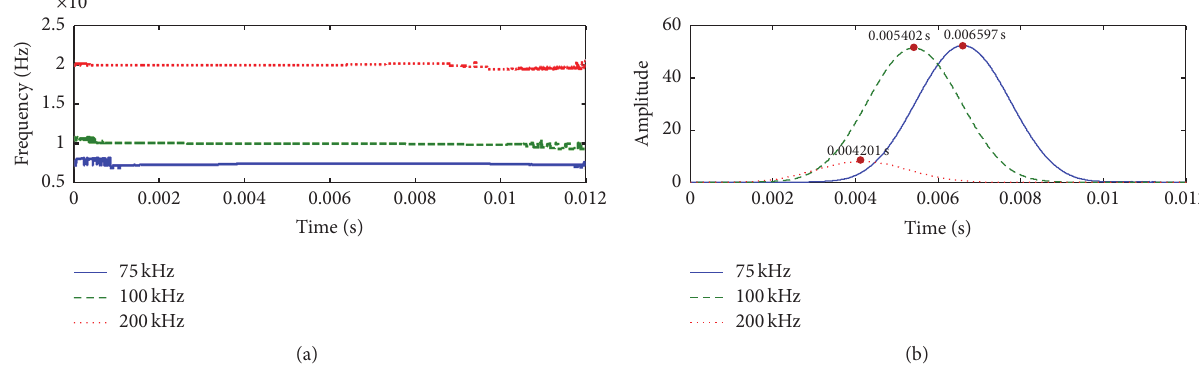
Figure 10: The primary IFs and IAs obtained by using the peak-track algorithm: (a) IF and (b) IA.